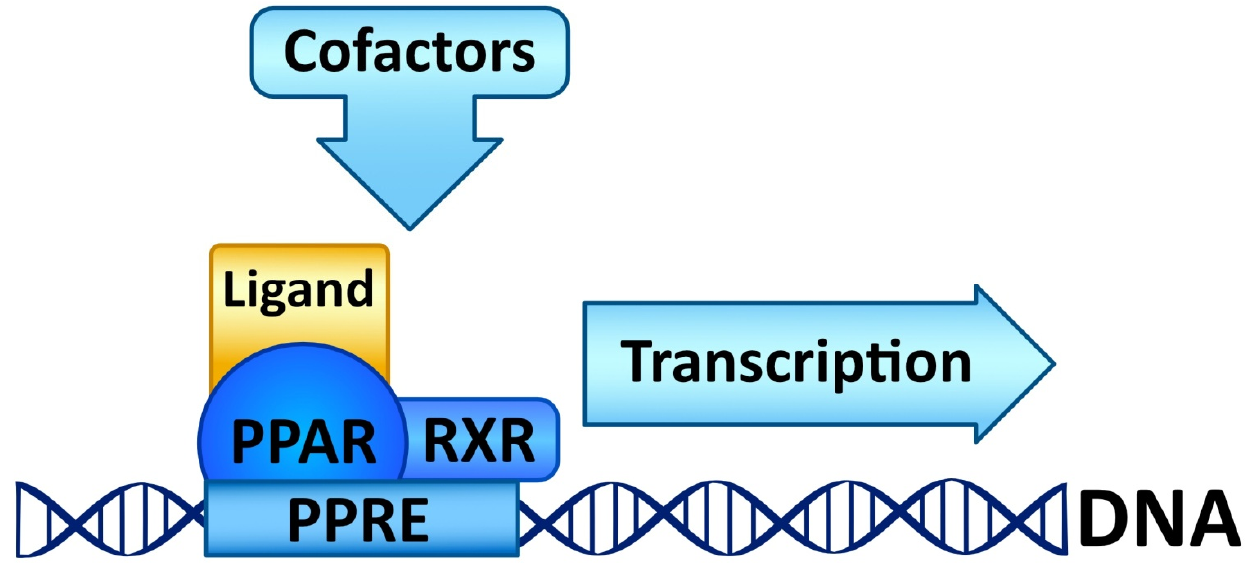
Figure 2. Activation of peroxisome proliferator activated receptors.